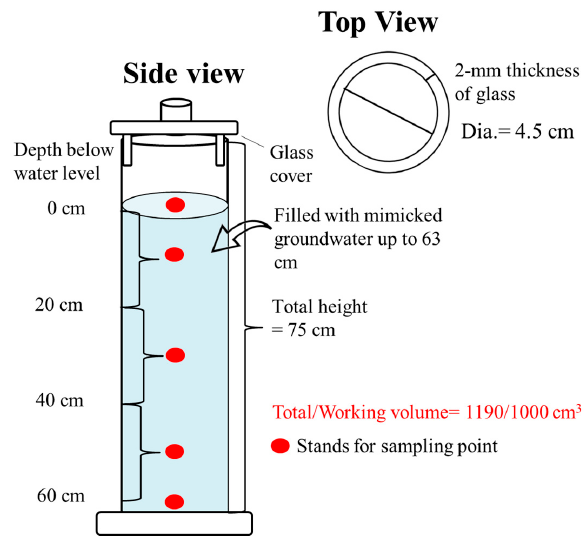
Figure 1. Setup of the water column reactor mimicking a groundwater system.